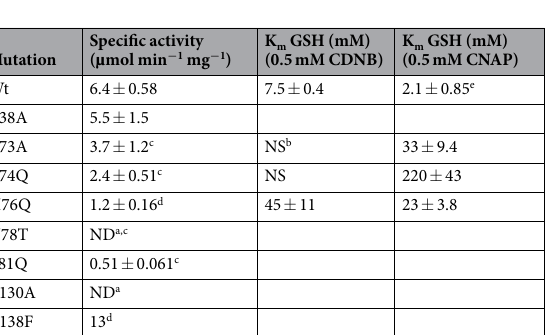
Figure 2. Shape and binding of GSH in MGST1. ( a ) Binding pocket for GSH and ( b ) residues in the vicinity of GSH. Residues R38 and R73 from one subunit (suffix A) and R130 and Y138 from a neighbour subunit (suffix C) in the trimer are in close contact with the same GSH molecule.